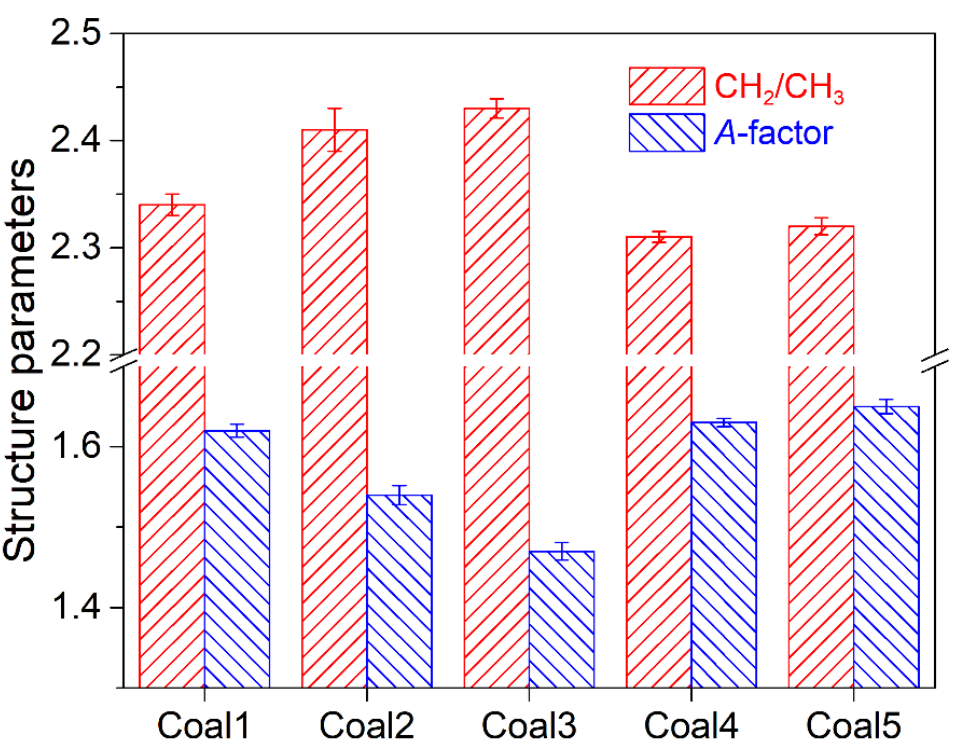
Figure 5. Structure parameters of bituminous coal samples obtained from the curve-fitting of ATR- FTIR spectra.